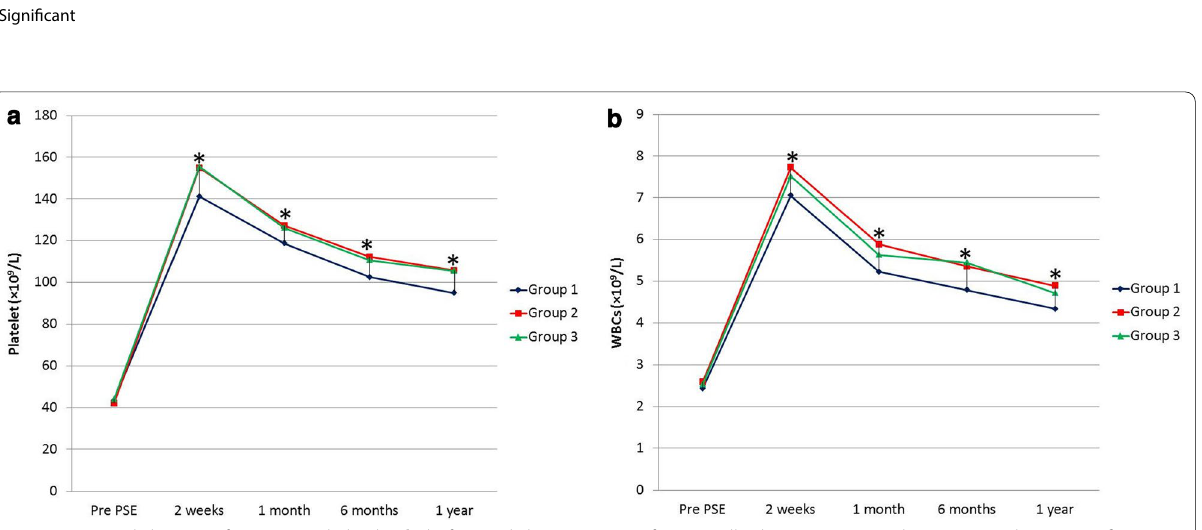
Fig. 4 Temporal changes of WBC ( a ) and platelet ( b ) before and along one year after PSE. All values are expressed as mean. *Indicates significance among three